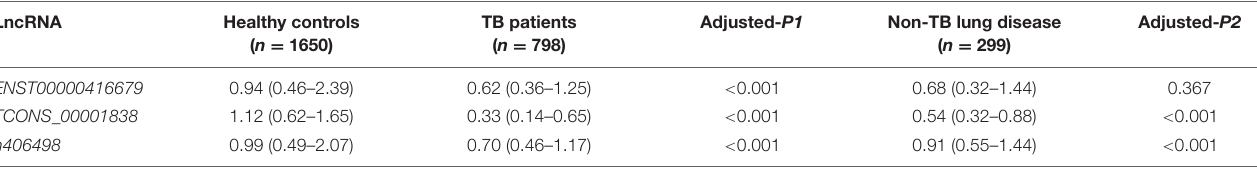
TABLE 3 | lncRNA expression in Selection cohort (2 − (cid:49)(cid:49) Cq ).